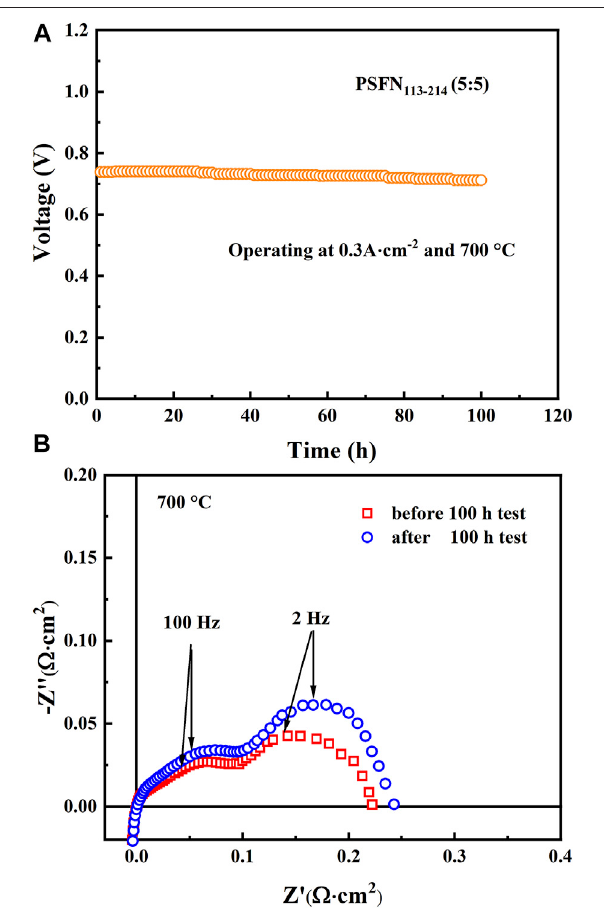
FIGURE9|(A) Thelong-termstabilitytestofasinglecellconstructed via PSFN 113-214 (5:5) cathode (B) cross-sectional view of it.